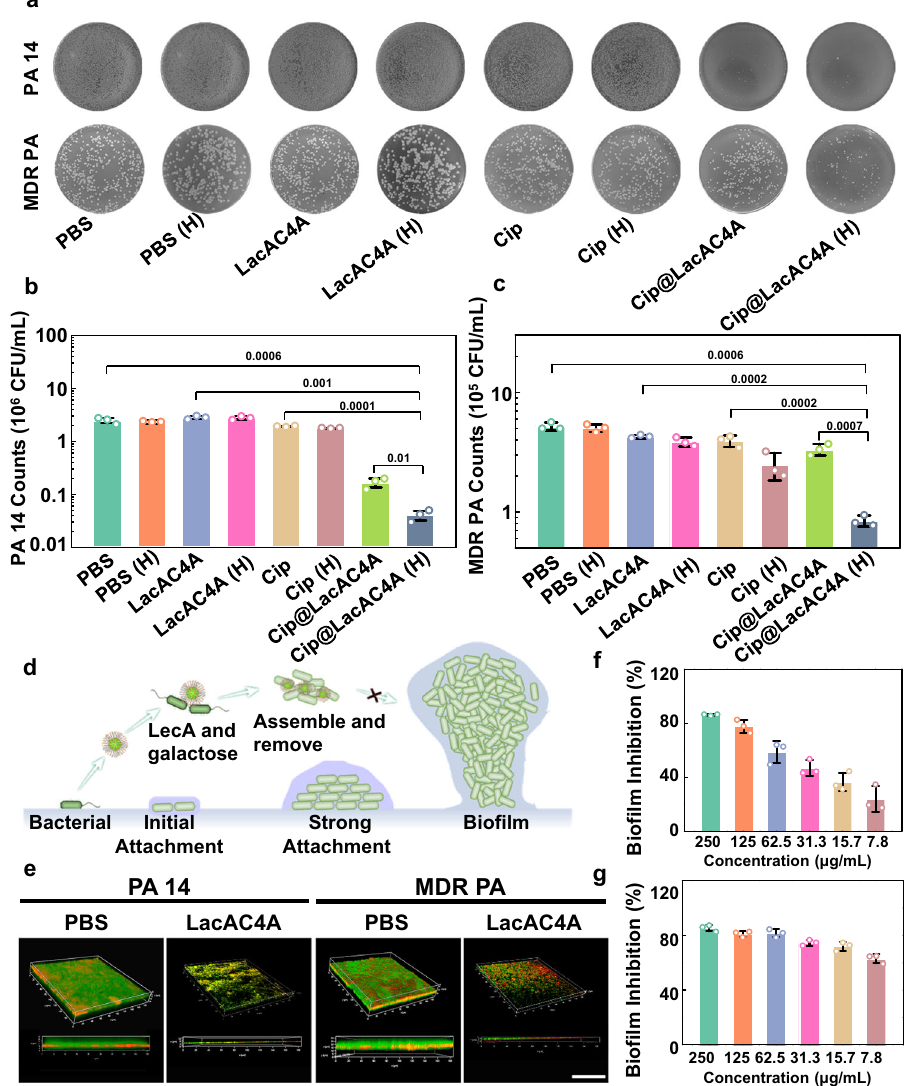
Fig. 5 | The antibacterial application and the ability to inhibit bio fi lm forma- tionofLacAC4A.a TheimagesofremainingbacteriaafterbeingtreatedwithPBS, LacAC4A, Cip and Cip@LacAC4A in normoxic and hypoxic conditions, respec- tively. The quanti fi cation of remaining PA 14 ( b ) and MDR PA ( c ) after various treatments. d The mechanism schematic of LacAC4A for inhibiting the formation